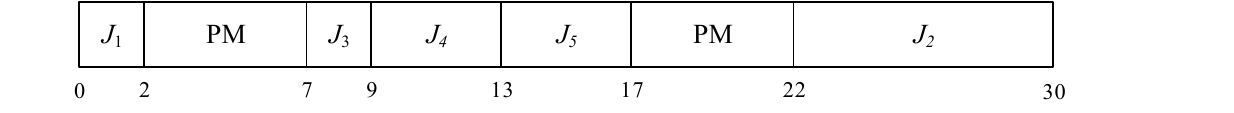
Figure 3. Gantt chart obtained by DP method.